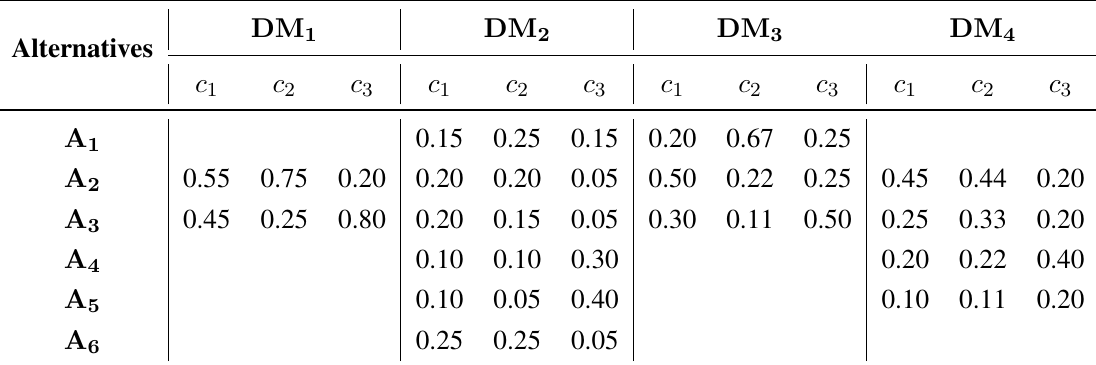
Table 10. Initial score matrices in emergency